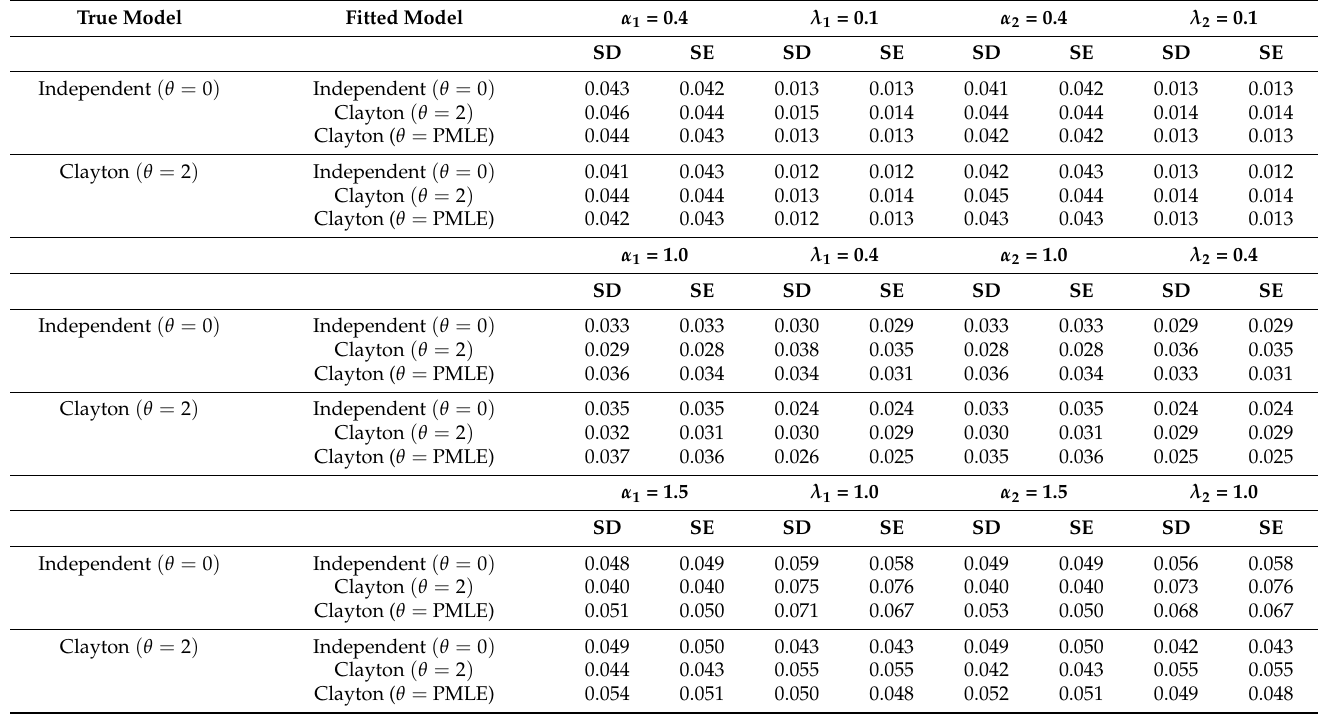
Table 4. The standard derivation (SD) and the average of SEs based on 1000 simulation